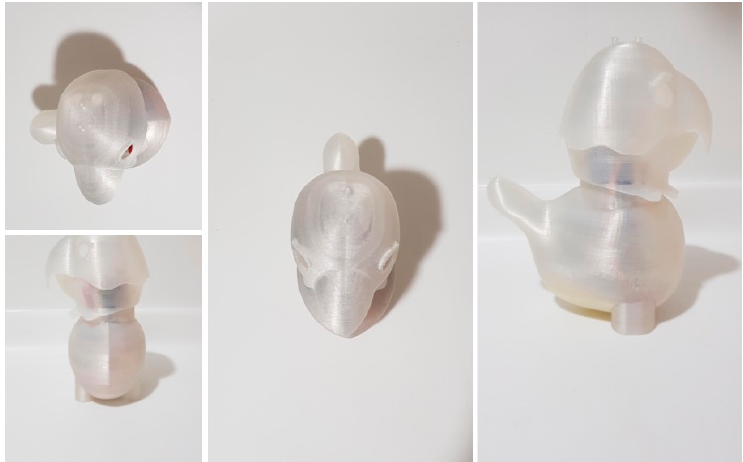
Figure 2 . KiliRo robot—physical architecture.